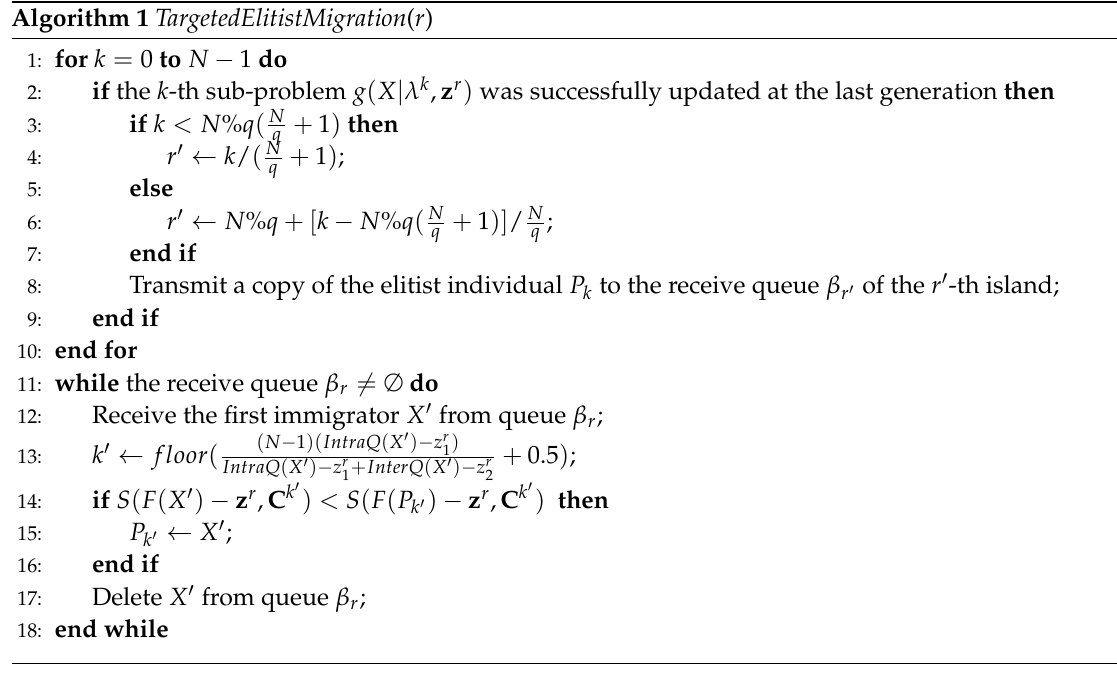
Algorithm 1 TargetedElitistMigration ( r